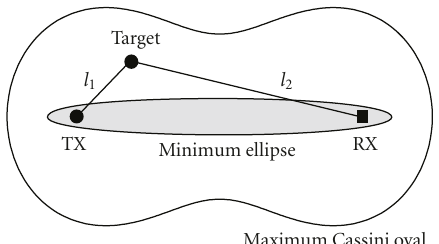
Figure 5: Minimum ellipse and maximum Cassini oval. The area inside the maximum Cassini oval is where the target can be detected. The gray area is a blind zone where targets cannot be detected.